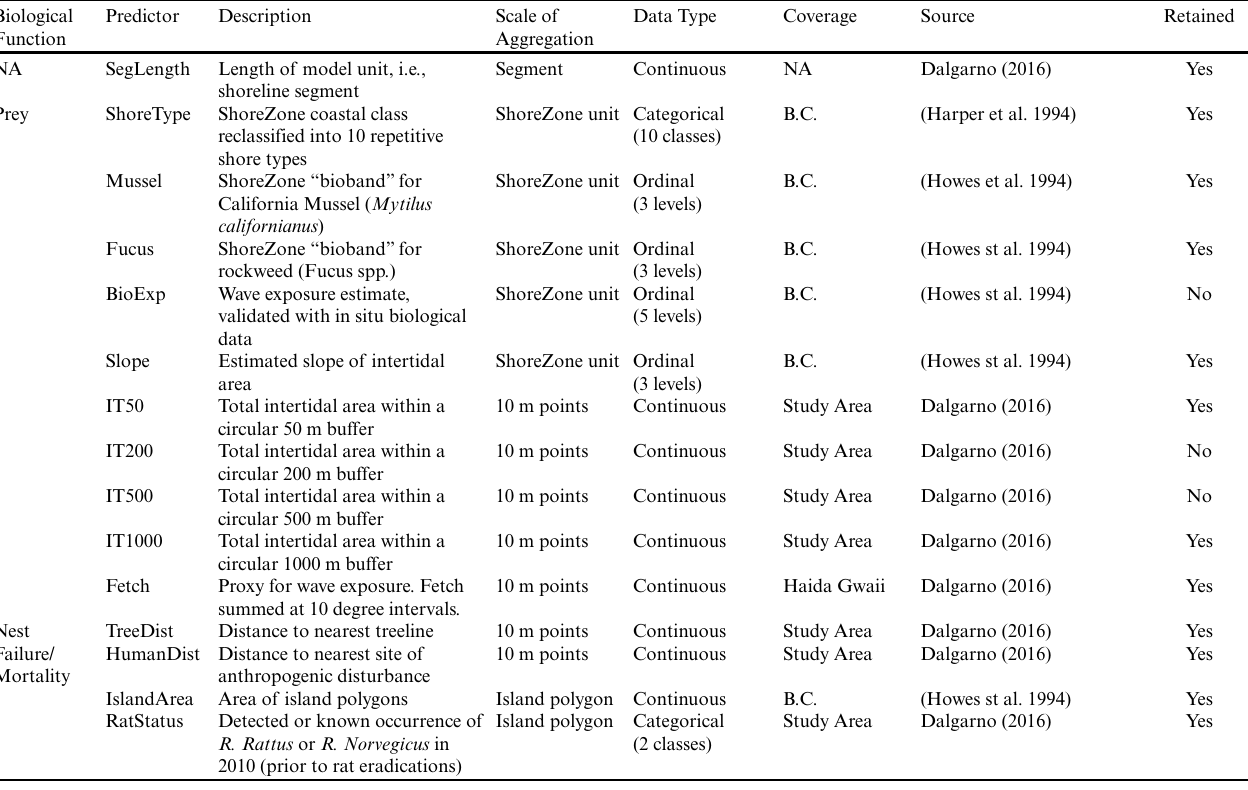
Table 1 . Predictors hypothesized to influence Black Oystercatcher ( Haematopus bachmani ) breeding pair occurrence at shoreline segments, selected a priori from a conceptual model and constrained by data availability. Scale of Aggregation: original resolution and geometry of the data before aggregated to shoreline segments; Retained: Indicates whether predictor was retained following pairwise correlation analyses (if rho > 0.7; the least ecologically relevant predictor was